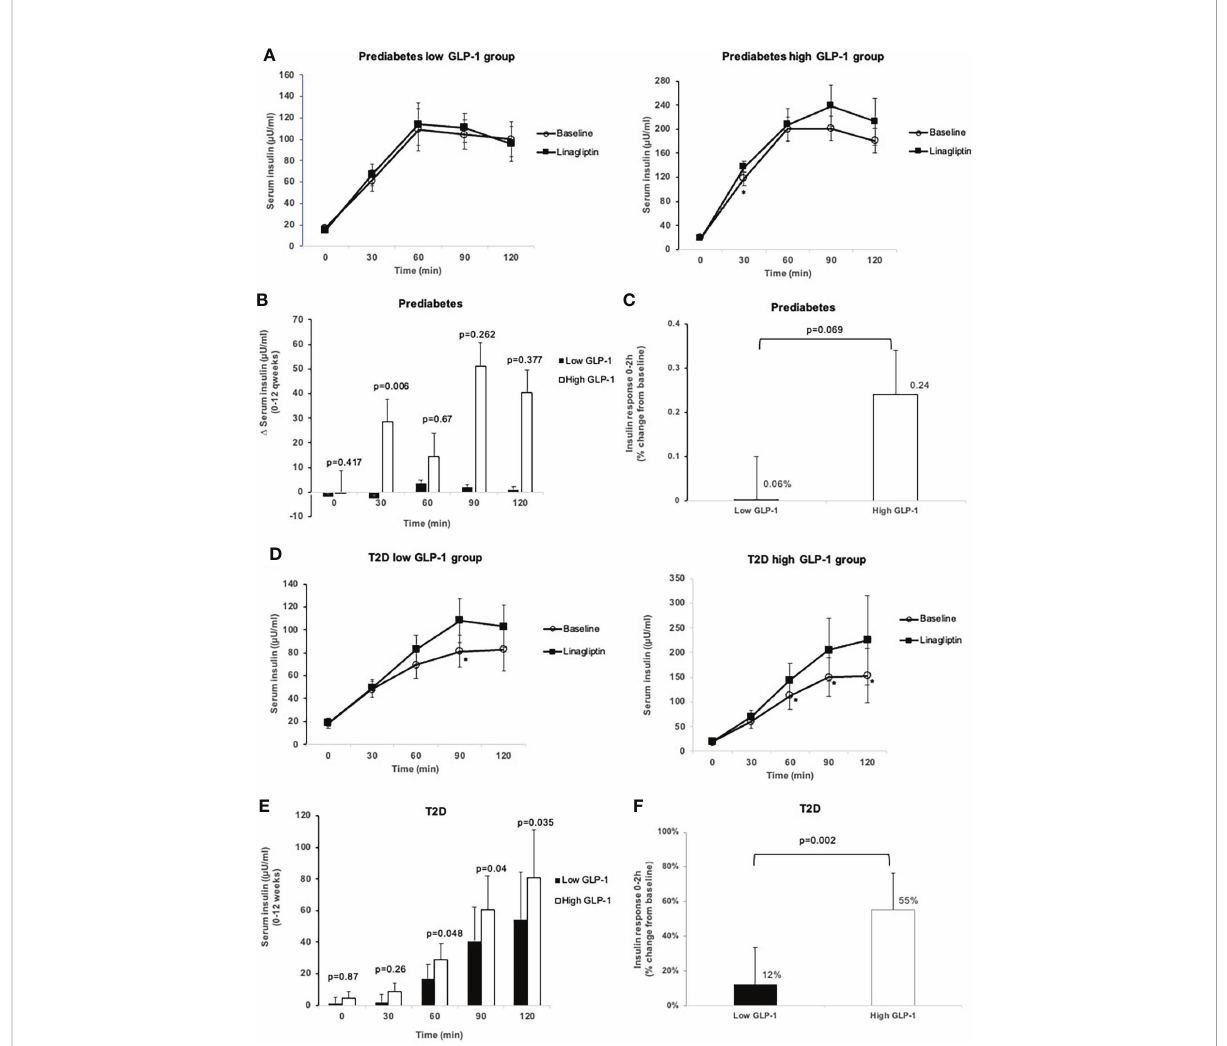
FIGURE 3 Comparison of insulin levels during OGTT at baseline and after 12-week treatment with linagliptin in low GLP-1 and high GLP-1 groups in prediabetes and T2D: Insulin level at each time point in prediabetes (A) ; change in insulin levels from 0 to 12 weeks in prediabetes (B) ; insulin response 0-2h (percent change from baseline) in prediabetes (C) ; insulin level at each time point in T2D (D) , change in insulin levels from 0-12 weeks in T2D (E) ; insulin response 0-2h (percent change from baseline) in T2D (F) . White circles: baseline; black squares: after linagliptin treatment; black bars: low GLP-1 group; white bars: high GLP-1 groups. T2D, type 2 diabetes. *p<0.05. Data shown are mean ± standard